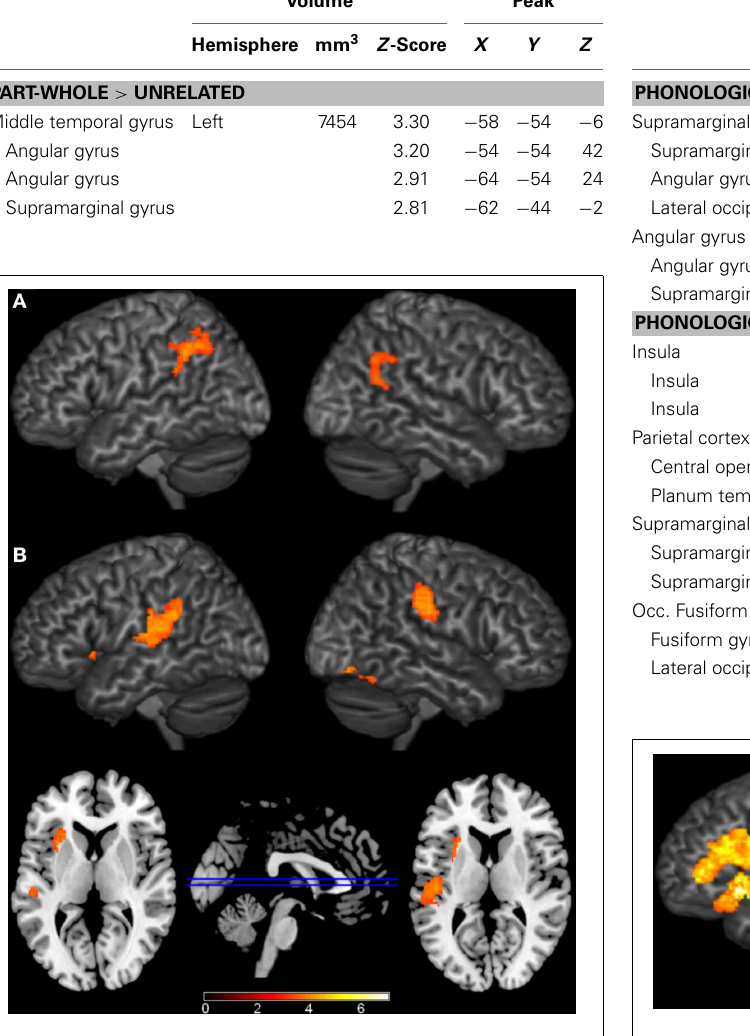
FIGURE 3 | Brain Activations to the Comparisons with the Phonological Condition. Areas (A) where the phonological condition elicited greater activation than the unrelated condition were found in bilateral parietal cortex. (B) Areas where the phonological condition elicited greater activation than the semantic conditions were found in bilateral parietal cortex, left insula, and right occipital cortex. The axial slices highlight the left insula and left Planum Temporale activations. Activations are scaled in terms of significant Z -values, and all comparisons are presented at a cluster-corrected threshold of p < 0 . 05.